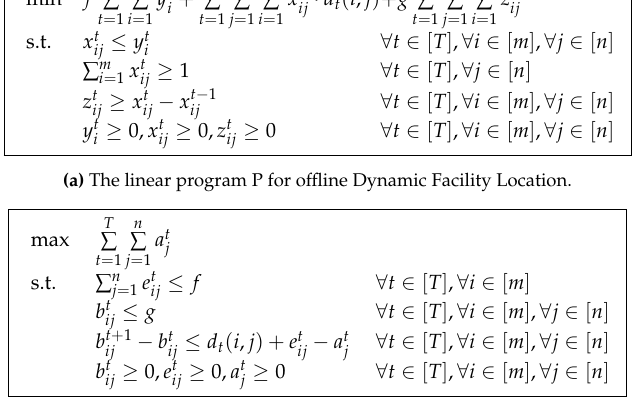
Figure 1. ( a ) The linear program P for dffline Dynamic Facility Location. ( b ) The dual D of the linear program